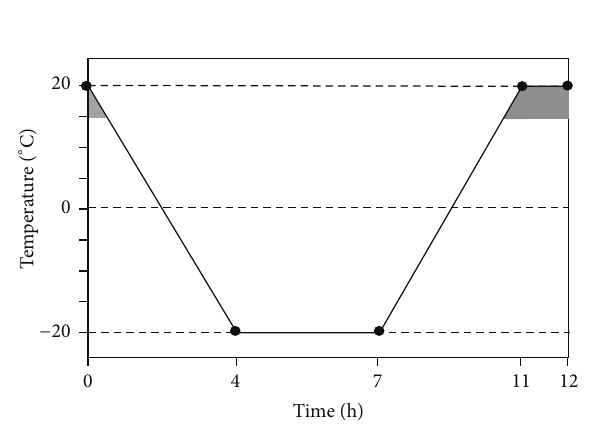
Figure 2: Temperature cycle.